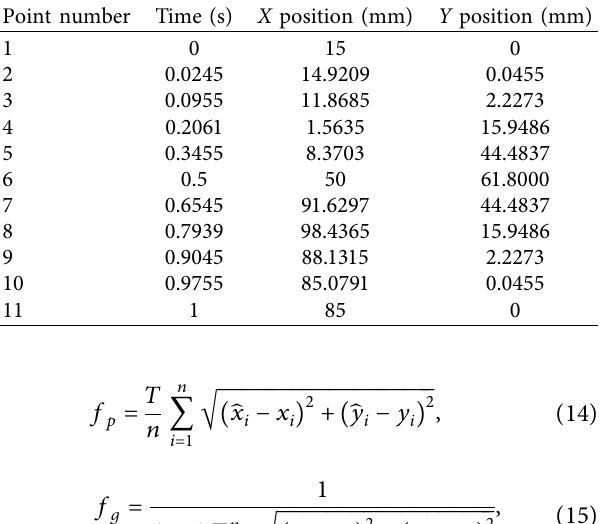
Figure 10: Temporal domain trajectory divisions. (a) Uniform time. (b) Chebyshev nodes. Table 6: Corresponding trajectory points of Chebyshev